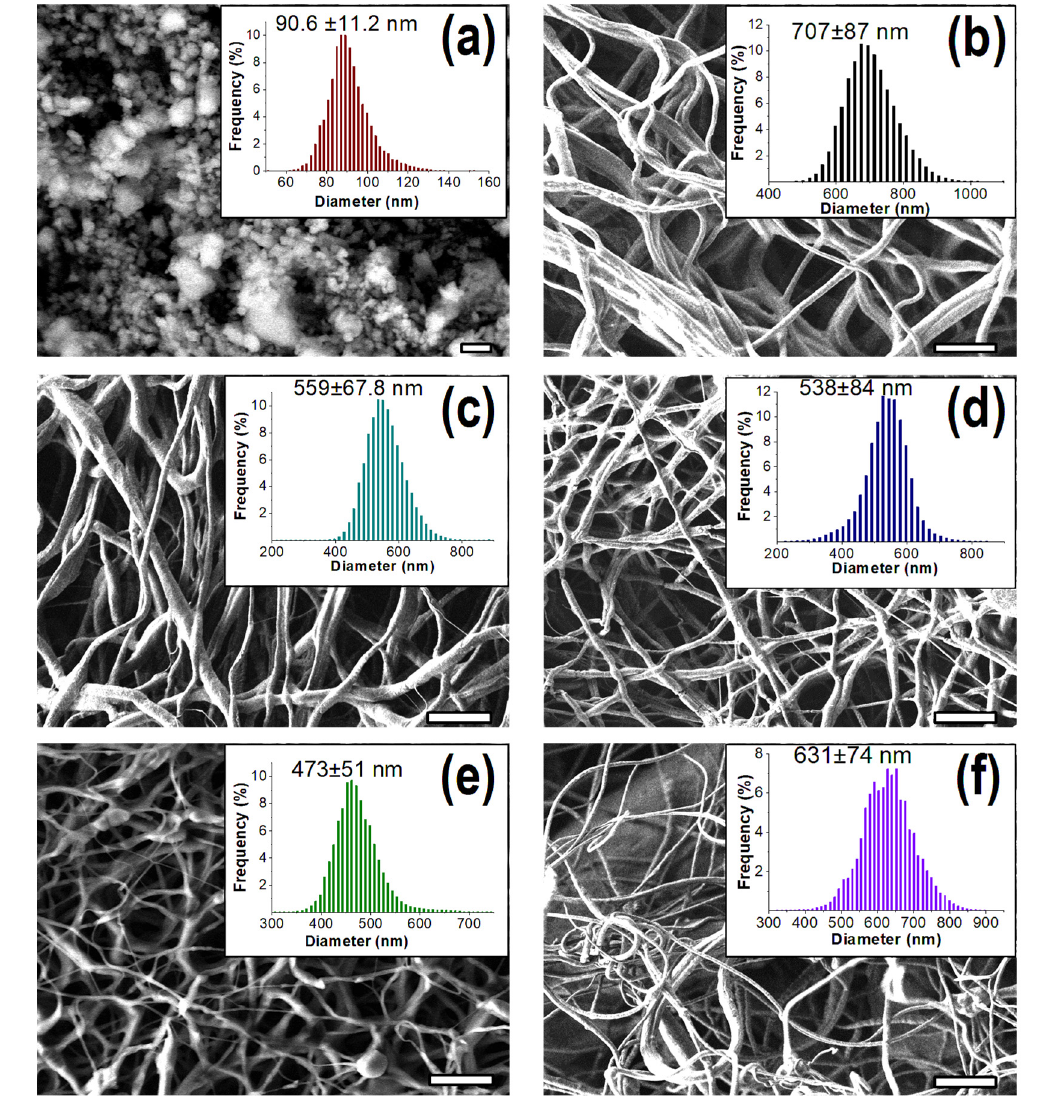
Figure 3. SEM images and size distributions of ball ‐ milled CP particles ( a ), PCL/PGS scaffold without CP ( b ) and PCL/PGS scaffold with 1% ( c ), 2.5% ( d ), 5% ( e ) and 10% ( f ) CP. Scale bars = 1 μ m ( a ) and 10 μ m ( b – f ).